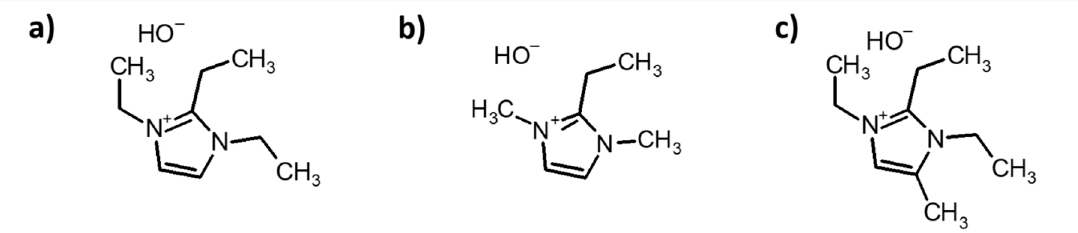
Figure 5. Chemical representation of the OSDAs ( a ) 1,2,3-triethylimidazolium hydroxide, ( b ) 2-ethyl-1,3-dimethylimidazolium hydroxide, and ( c ) 1,2,3-triethyl-4-methylimidazolium hydroxide, using